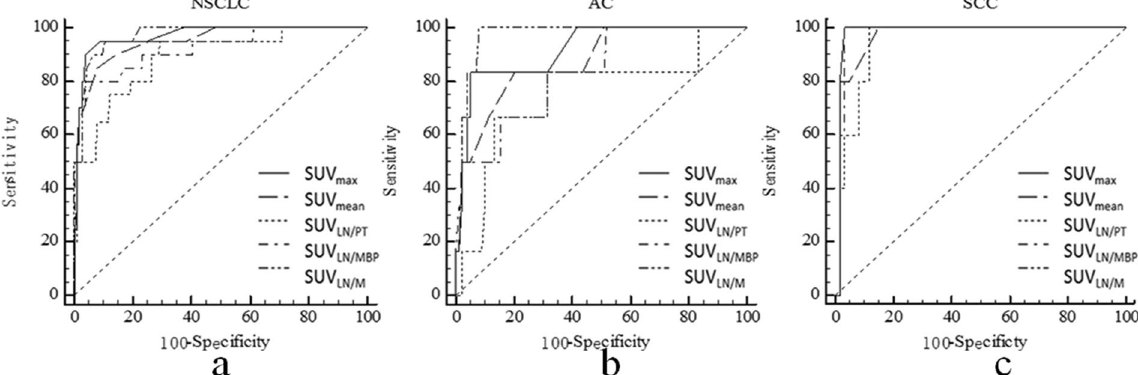
Figure 1. Receiver operating characteristic curves for the semi-quantitative assessment in patients with NSCLC ( a ), adenocarcinoma ( b ) and squamous cell cancer ( c ) at 18 F-Alfatide